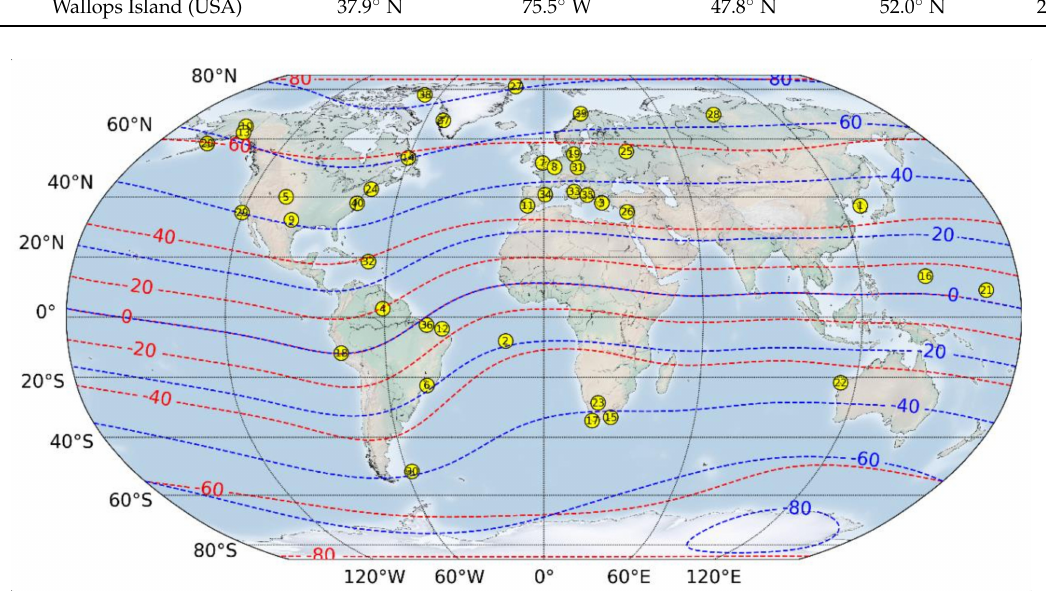
Figure 1. Global view of the ionosonde stations listed in Table 1. The yellow circles depict the ionosonde stations location with the corresponding identification number (Table 1, first column). Blue dashed curves depict the QD magnetic parallels, while red ones depict the modip